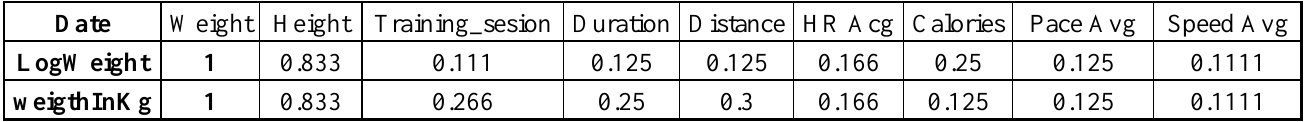
Table 10. Similarity matrix for the sets of neighbors of date